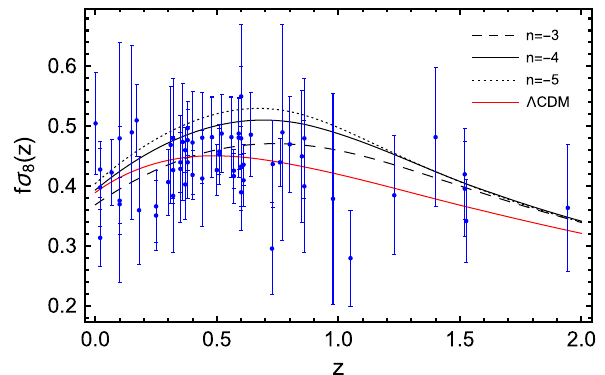
Fig. 4 It is shown the evolution of the weighted growth rate f σ 8 ( a ) for several different values of the parameter n and for Λ CDM model. In the plot we have used the full RSD f σ 8 dataset of Table II in Ref. [109]. The prediction for n = − 3 lies some ∼ 5 per cent below the Λ CDM prediction, and therefore alleviating the σ 8